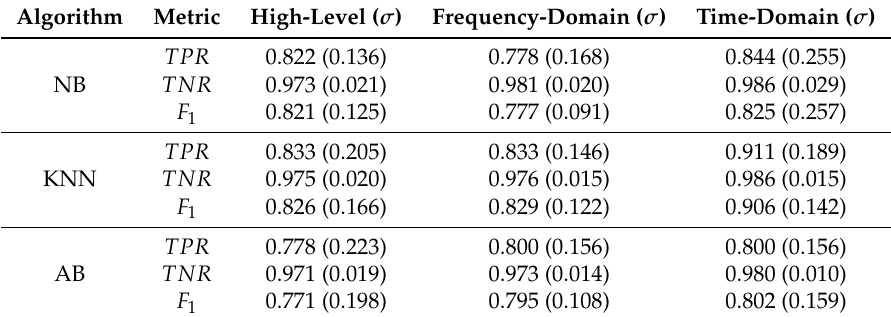
Table 8. Classification results using weighted averages corresponding based on three types of features: high-level, frequency-domain, and time-domain. σ is the weighted standard